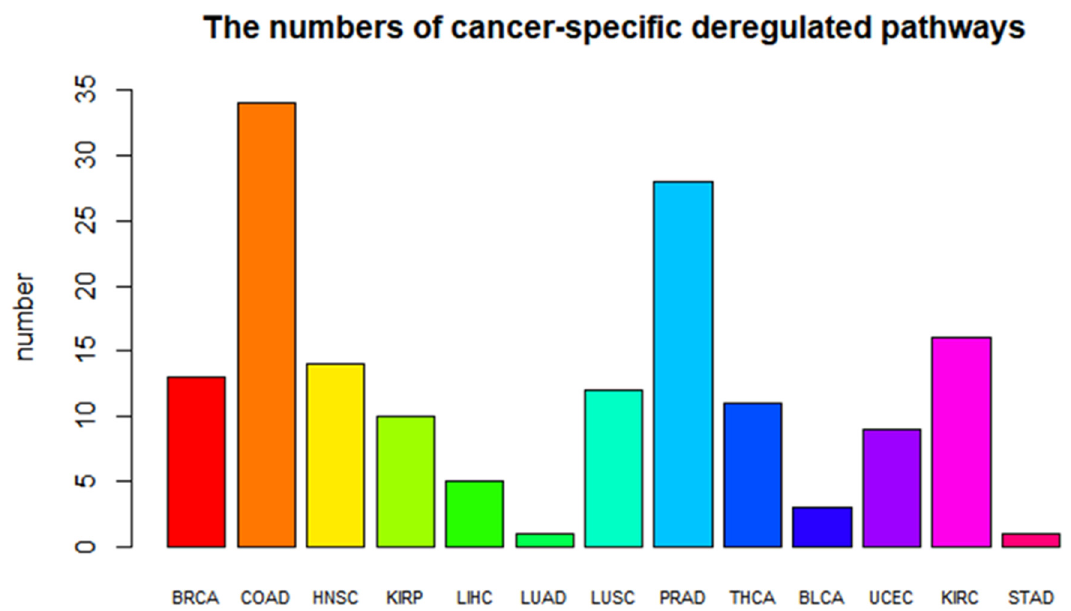
Figure 3. Barplot of the numbers of cancer-specific deregulated pathways. Different colors represent different types of